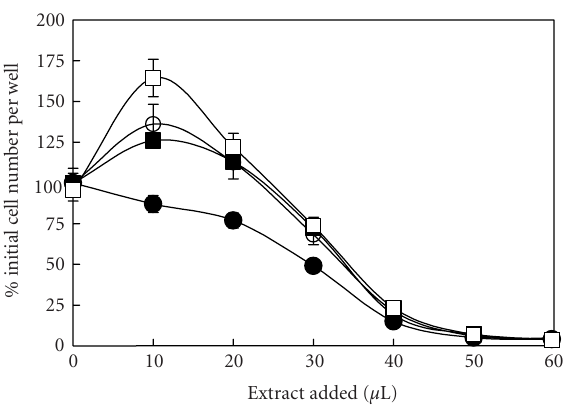
Figure 4. Graphs showing the ability of the three skin extracts D shown in Figure 3 to inhibit fetal fibroblasts (FF) growth. The assay was made after 3 days growth and records the increase in cell number relative to the control (100% at 0 extract). The amount of extract represented in the added volumes was ∼ 50